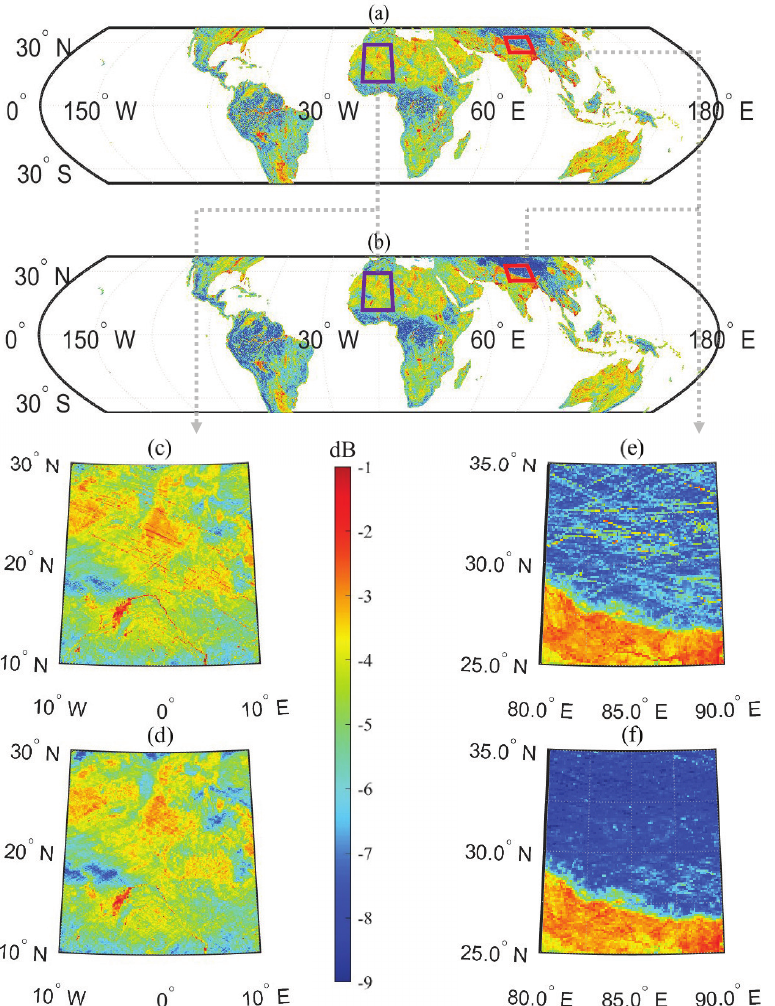
Figure 1. Comparison between monthly: ( a , c , e ) mean and ( b , d , f ) median of uncalibrated Γ for January 2020. The mean Γ suffer from track-wise biases, shown by demonstrations of two boxed regions (purple and red boxes) in ( a , b ). The zoomed views of these two boxed areas are exhibited in ( c – f ), respectively. The spatial resolution of each subplot is 0.1 ◦ × 0.1 ◦